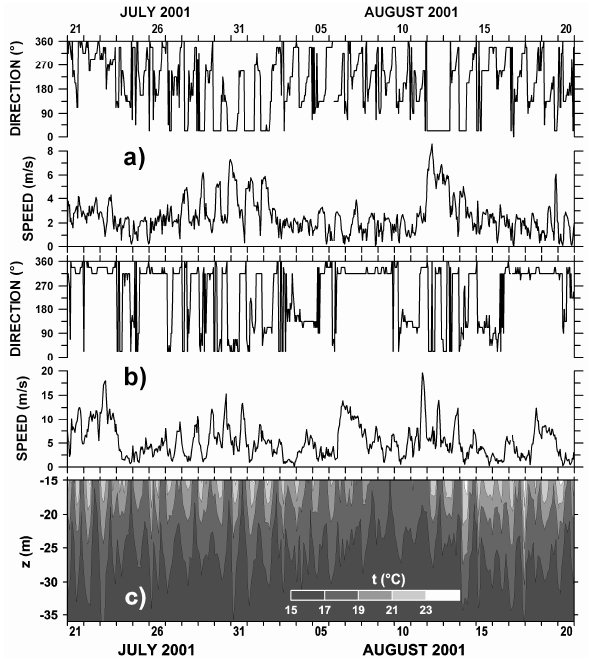
Figure 3. (a) Wind speed and wind direction at Dubrovnik meteorological station, for the interval extending from 21 July to 20 August 2001. (b) The same as in (a), except for Komiža meteorological station. (c) Vertical temperature distribution between 15 and 36 m at Cape Struga for the same period.